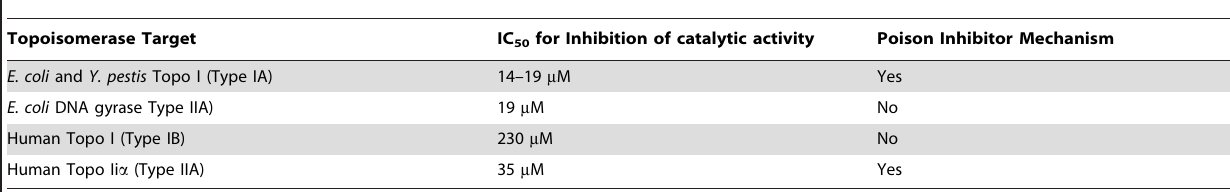
Table 2. Summary of inhibitory action of anziaic acid on topoisomerases